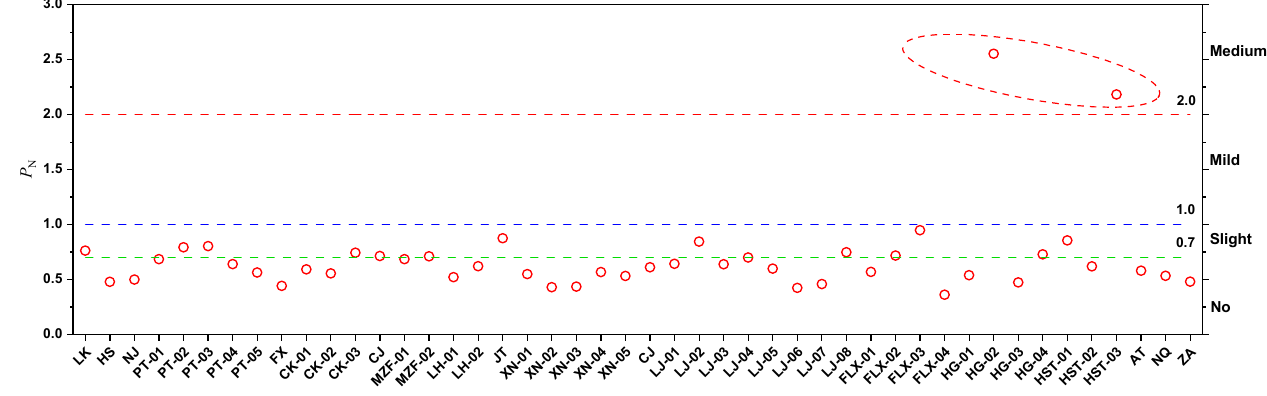
receive greater attention.